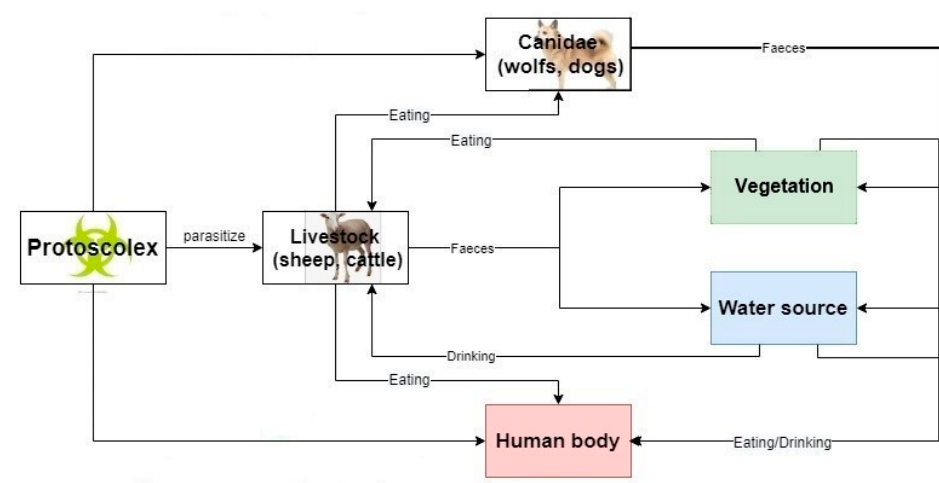
Figure 3. Infection process of hydatid in biological chain.